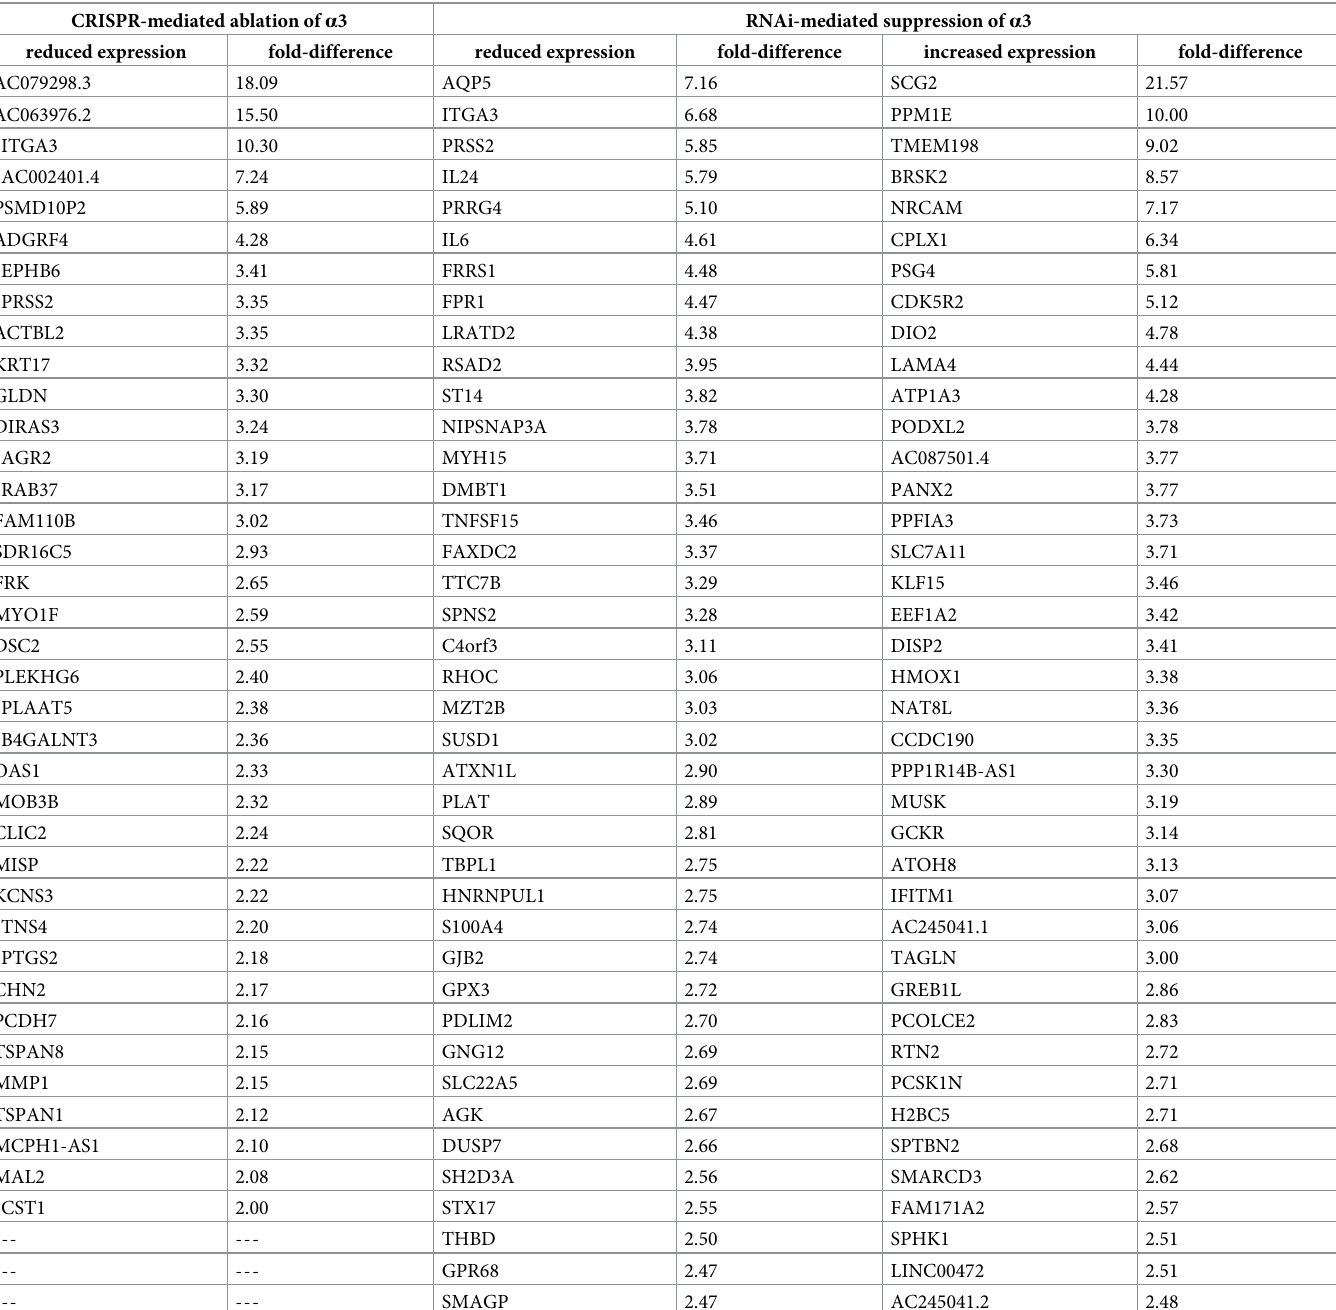
Table 1. Differentially expressed genes in cells with CRISPR-mediated ablation or RNAi-mediated suppression of ITGA3 . CRISPR-mediated ablation of α 3 RNAi-mediated suppression of α